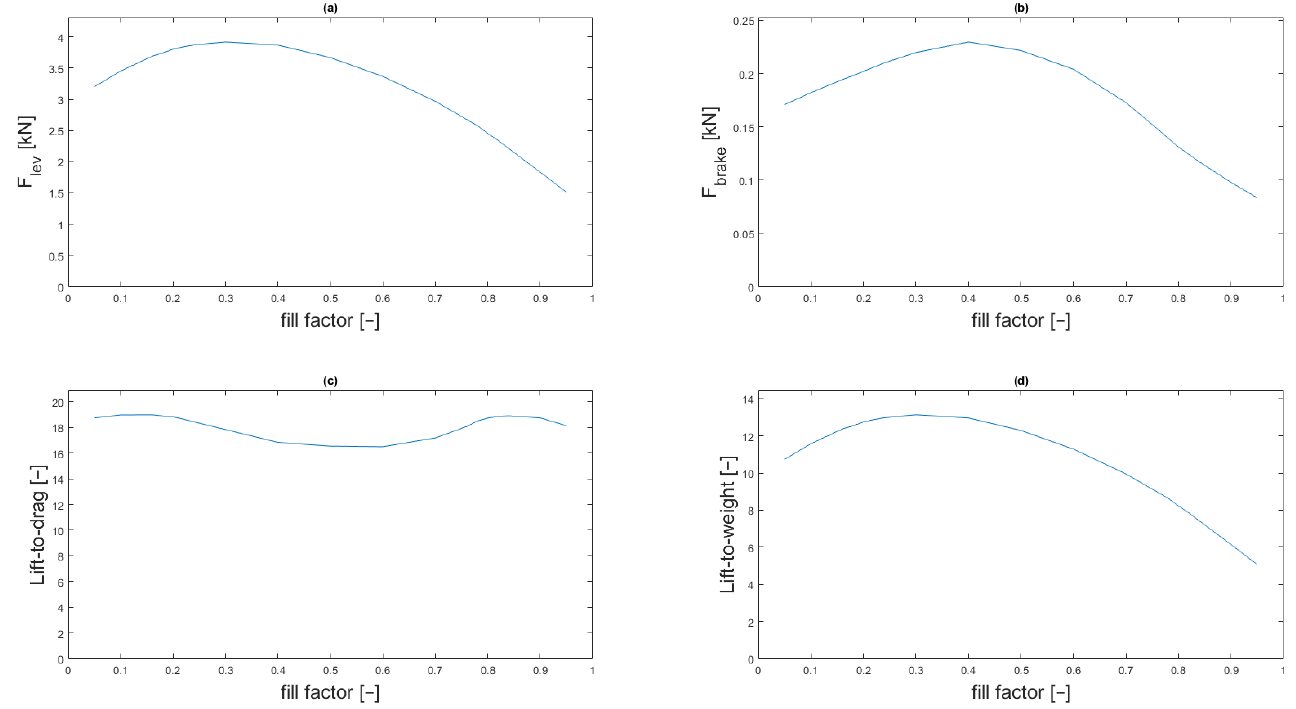
Figure 5. Results obtained from transient simulations for v max = 100 m/s. ( a ) Levitation force as a function of fill factor, ( b ) braking force as a function of fill factor, ( c ) lift-to-drag ratio as a function of fill factor and ( d ) lift-to-weight as a function fill factor.